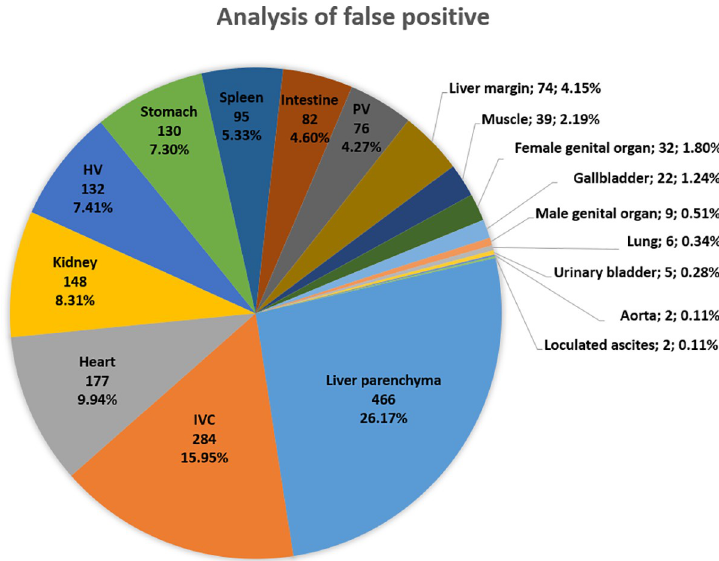
Fig 9. Analysis of 1781 false positive images. (IVC: inferior vena cava; HV: hepatic vein; PV: portal vein).